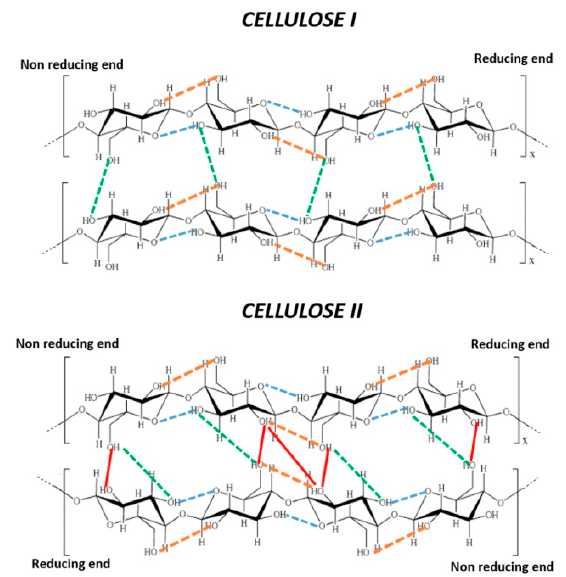
Figure 1. Intermolecular and intramolecular hydrogen bonds in structures CI and CII: Intramolecular 2(OH) … O-6 (yellow dashes), intramolecular O(3)H–O pyranosidic (blue dots), intermolecular O(6)H–O(3 ′ ) (green dashes and dots), and intermolecular O(2)H–O(2) and O(6)H–O(2 ′ ) (red lines).